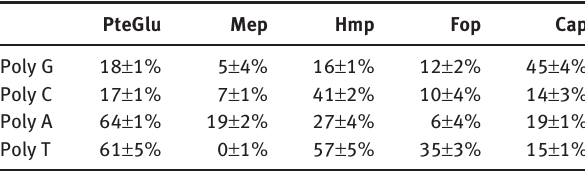
DNA nucleotide concentration: 500 μ